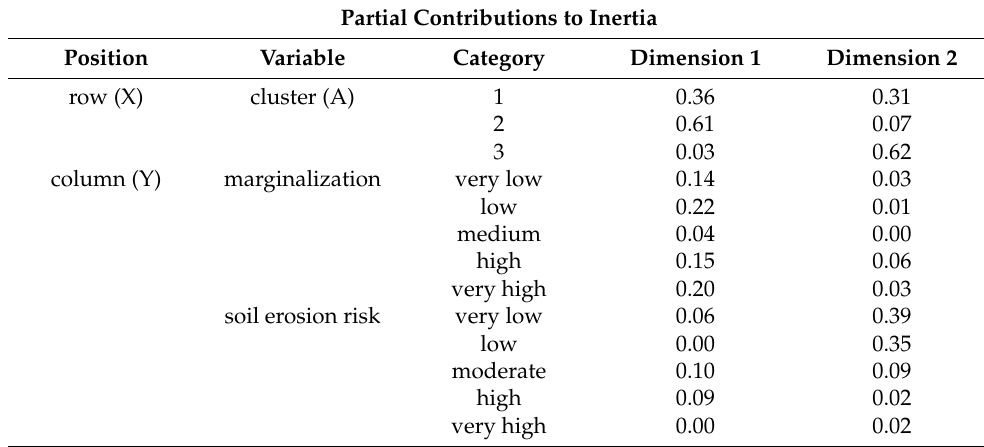
Table A1. Partial variable contributions to inertia for each MCA